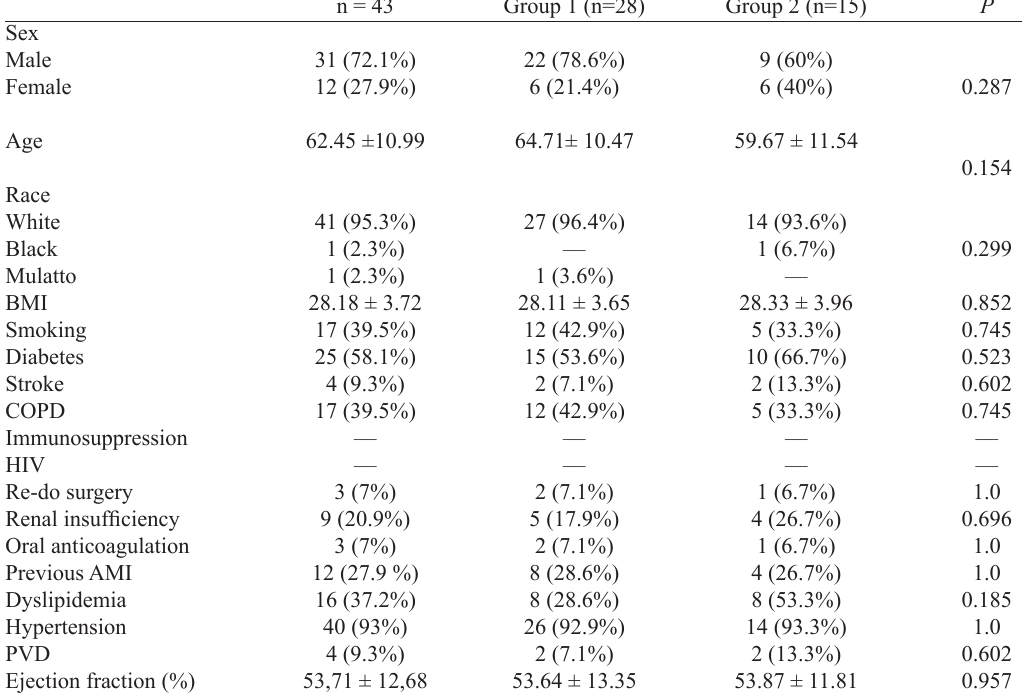
Table 1. Demographic